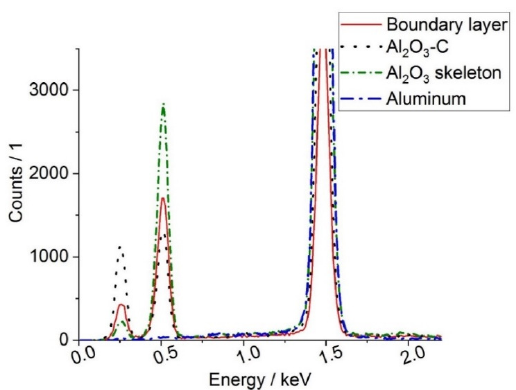
Figure 8. EDX analyses of the newly formed boundary layer (red), Al 2 O 3 -C coating (black), Al 2 O 3 skeleton filter (green), and solidified aluminum (blue) .